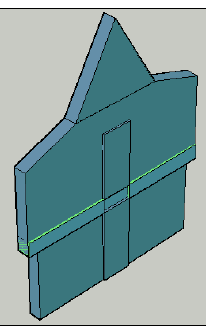
Figure 16 3D model of building part